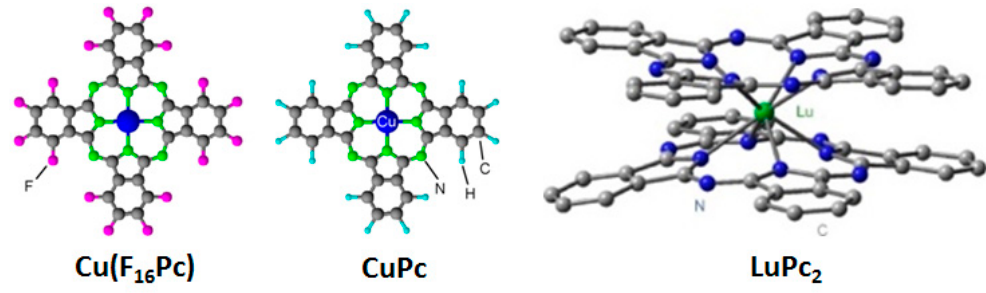
Figure 3. Structures of Cu(F 16 Pc), CuPc and LuPc 2 .